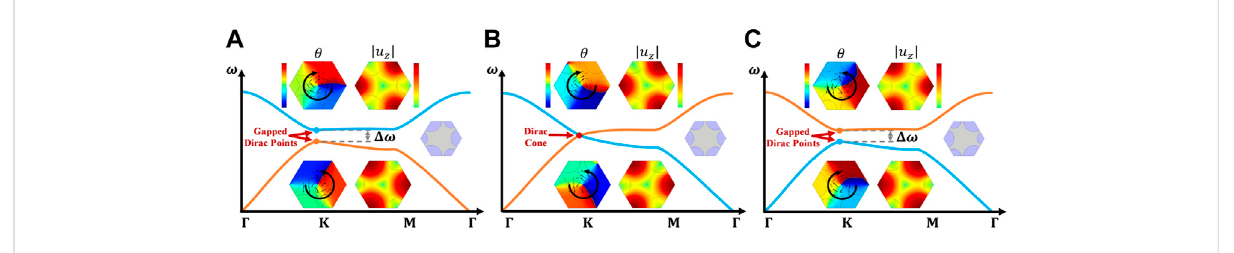
FIGURE 3 The band structures of C3-symmetric hexagonal UCs with setting (A) R 1 (cid:2) 0 . 3 A , R 2 (cid:2) 0 . 2 A , (B) R 1 (cid:2) R 2 (cid:2) 0 . 25 A and (C) R 1 (cid:2) 0 . 2 A , R 2 (cid:2) 0 . 3 A ( A denoting the lattice constant). The corresponding UCs, the out-of-plane displacement fi elds, and phase fi elds at the (gapped) Dirac points are inserted as